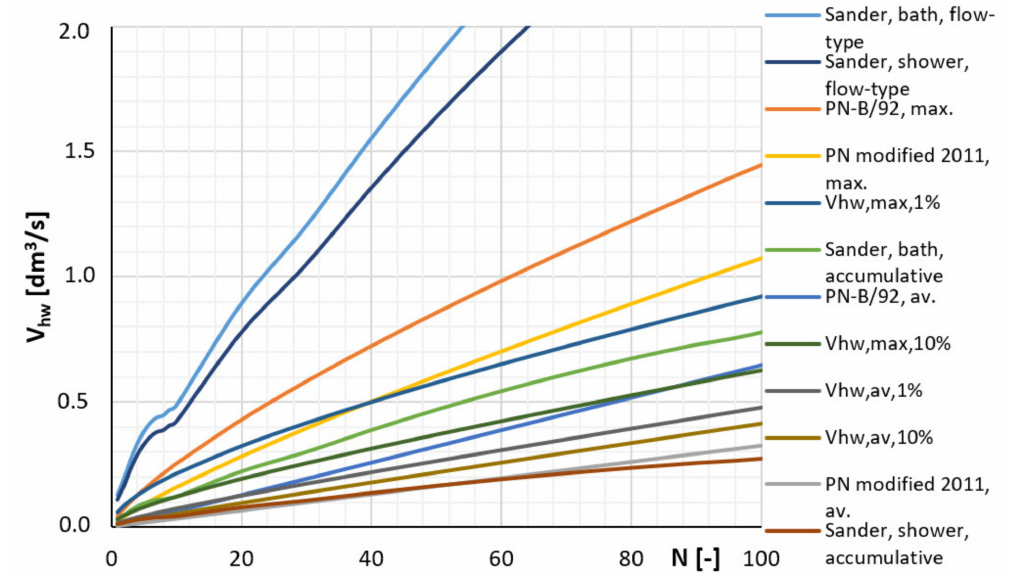
Figure 4. Comparison of hot water consumption calculated with different formulas the number of flats: N =